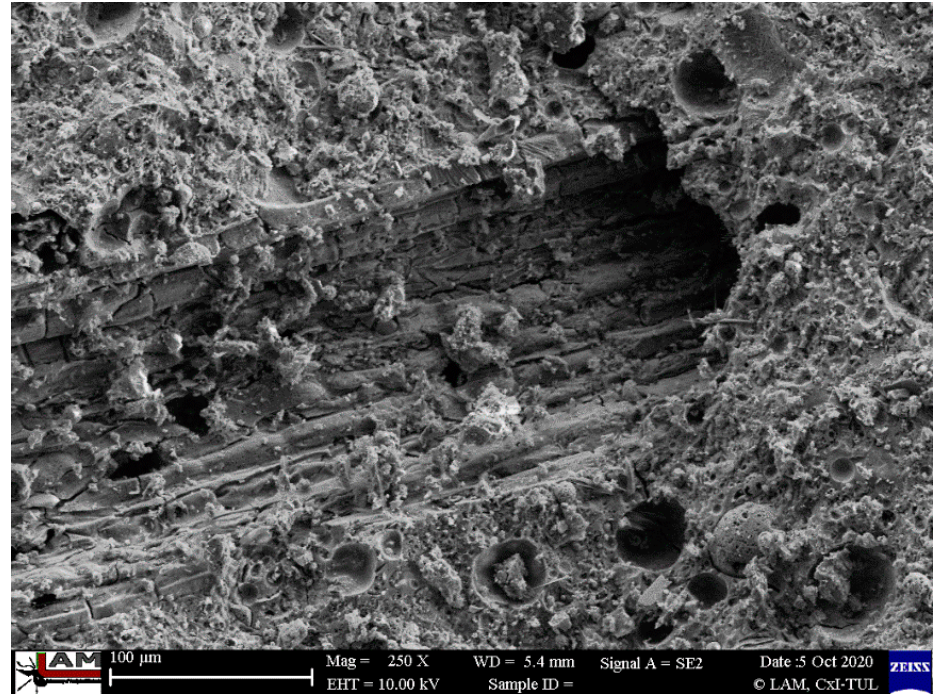
Figure 13. Microstructure of the cast samples reinforced with flax fibers with very good visible cohesion between the sample and the matrix.